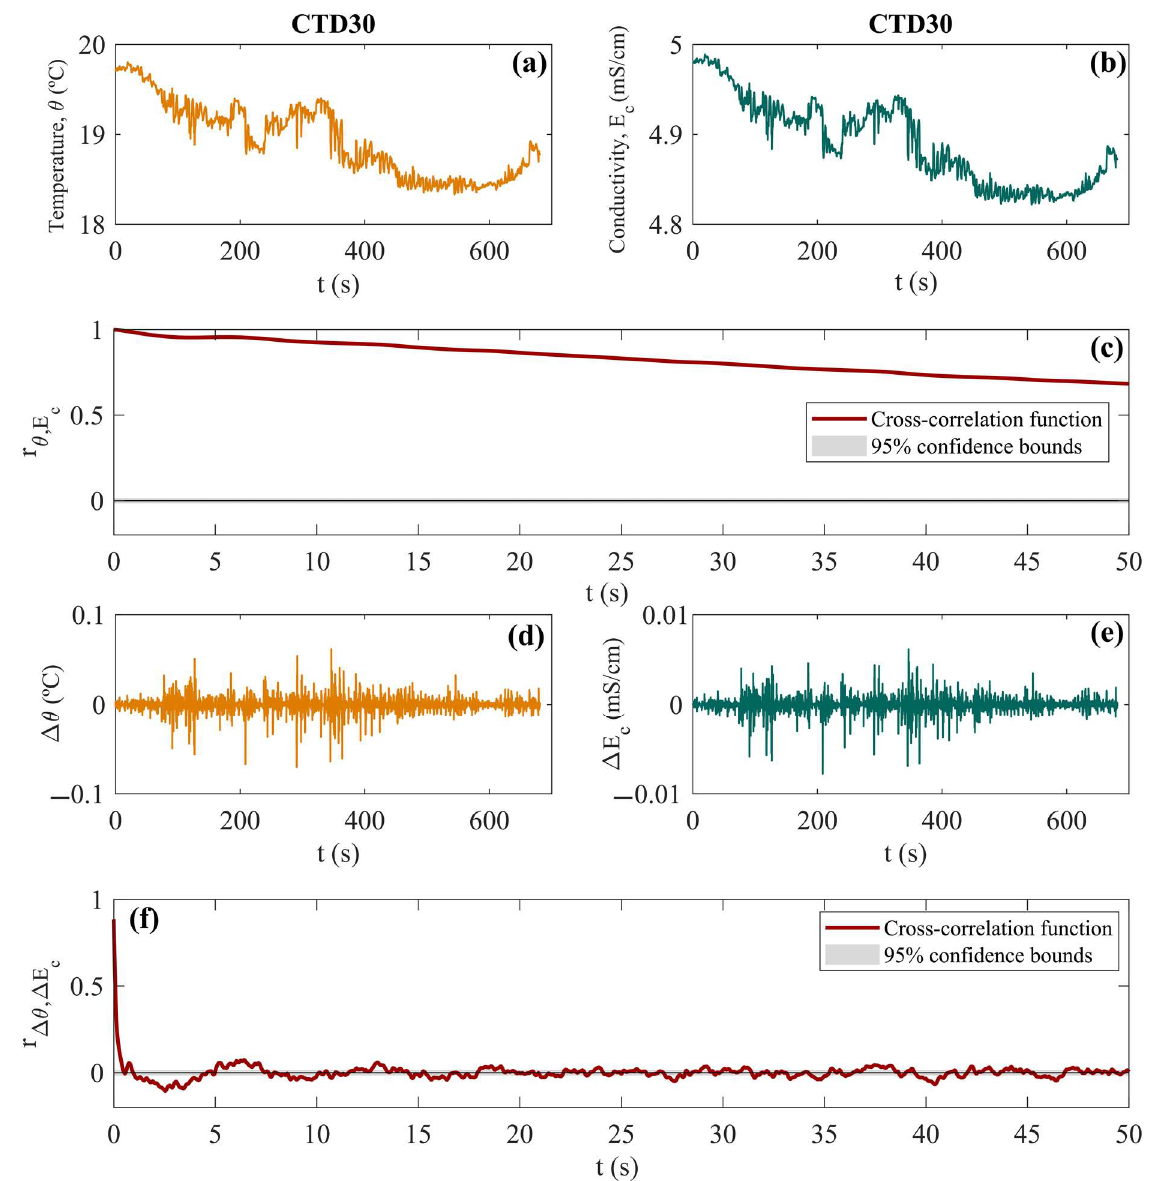
Figure 3. ( a ) Temperature, θ, and ( b ) conductivity, E c, time series of CTD30 collected as part of the high-resolution grid. The similarity between both variable fluctuation patterns as well as the occasional distinct peaks is remarkable, and ( c ) their normalised cross-correlation coefficient r θ,Εc showing a strong correlation for short times (t < 3.5 s), which remains large even for long times. ( d ) The differentiation with respect to time of the temperature time series, Δθ, ( e ) the differentiation with respect to time of the conductivity time series, ΔE c , and ( f ) the normalised cross-correlation coefficient r Δθ,ΔEc of the differentiation with respect to time of temperature and conductivity time series going rapidly to zero, at the crossing point 0.6 s. In grey is indicated the 95% confidence bounds, where the time series are uncorrelated.